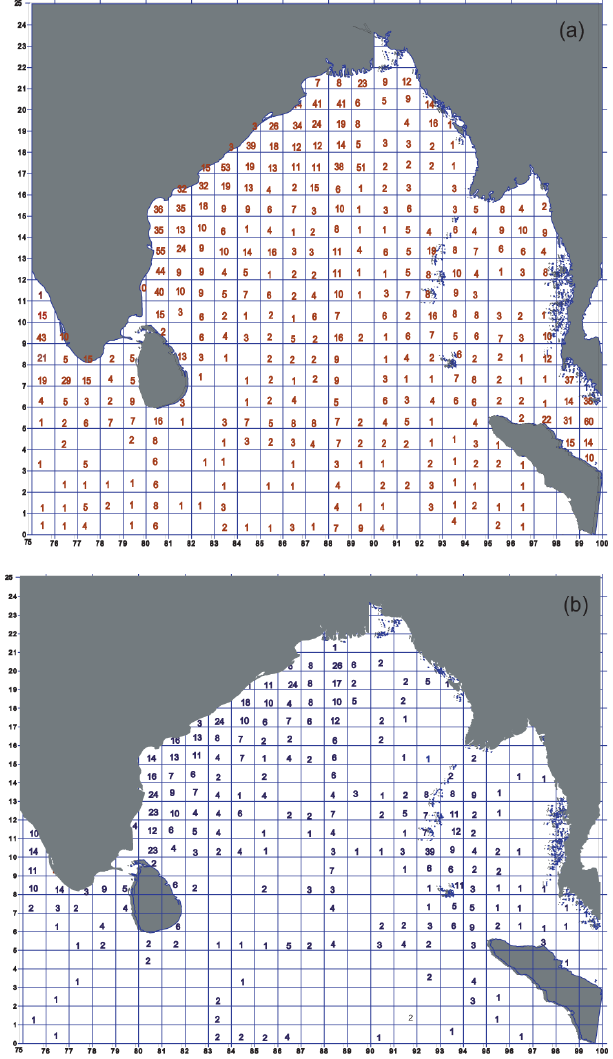
Figure 3. Total number of profiles of (a) nitrate and (b) chloro- phyll a available at each of the 1 ◦ latitude × 1 ◦ longitude